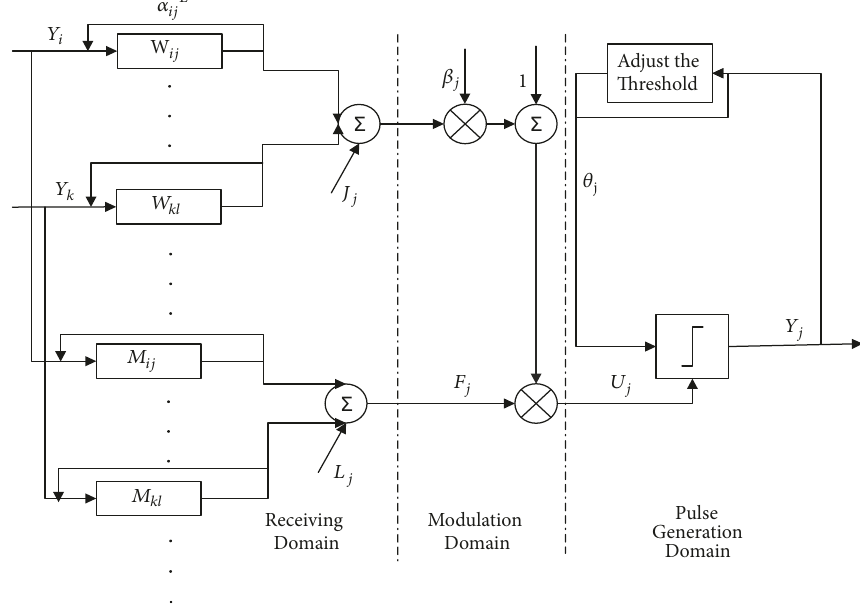
Figure 1: Basic structure of PCNN model